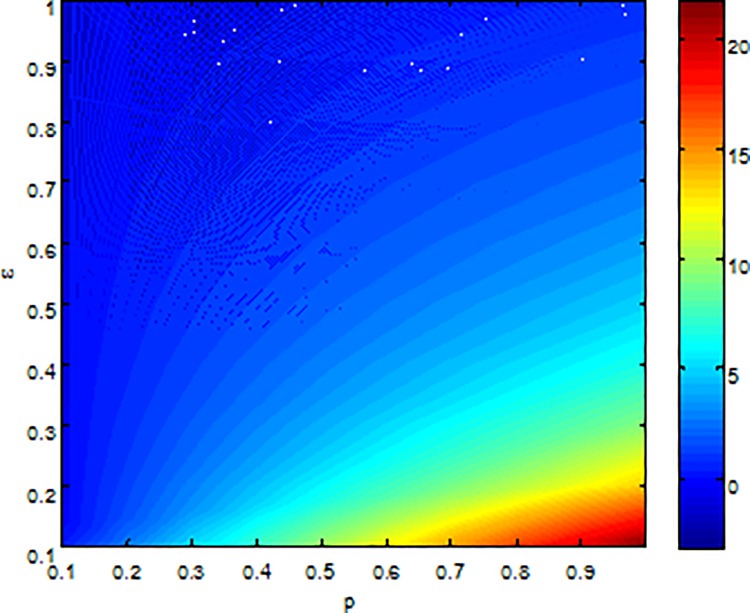
An illustration of effect of p andεon I*.